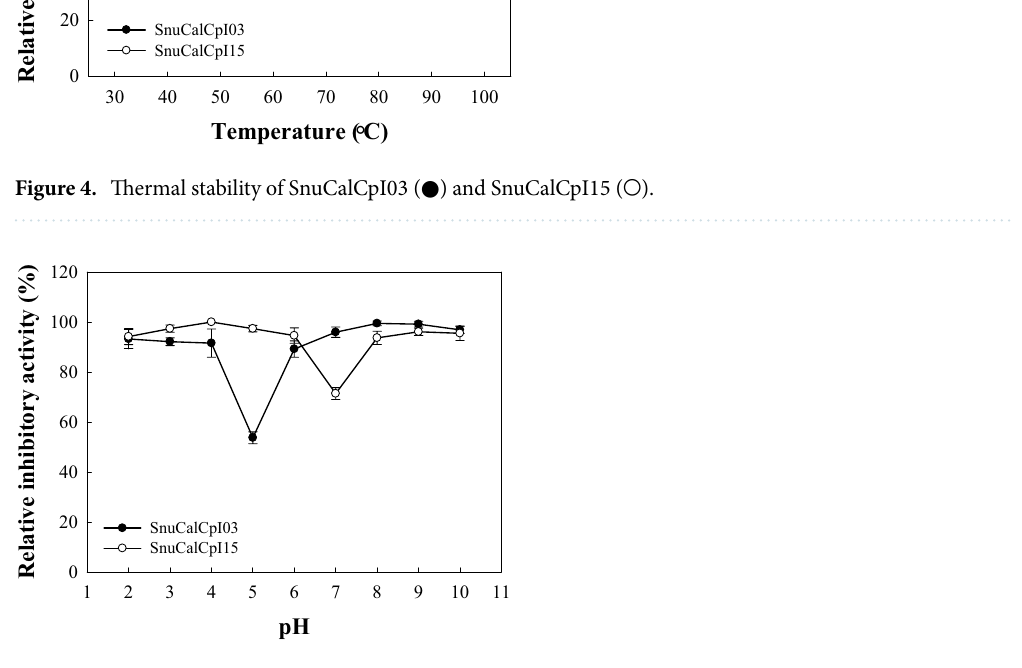
Figure 5. pH stability of SnuCalCpI03 ( ● ) and SnuCalCpI15 ( ○